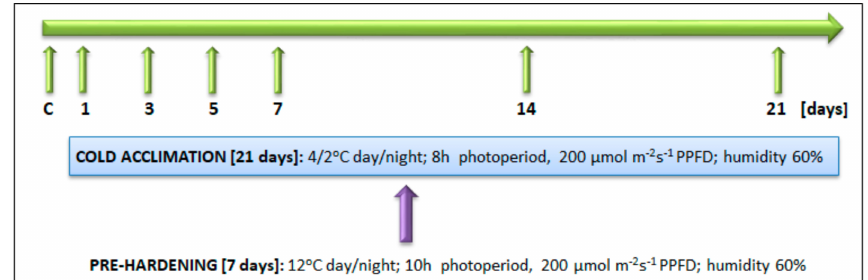
Figure 9. The scheme illustrating the experimental set